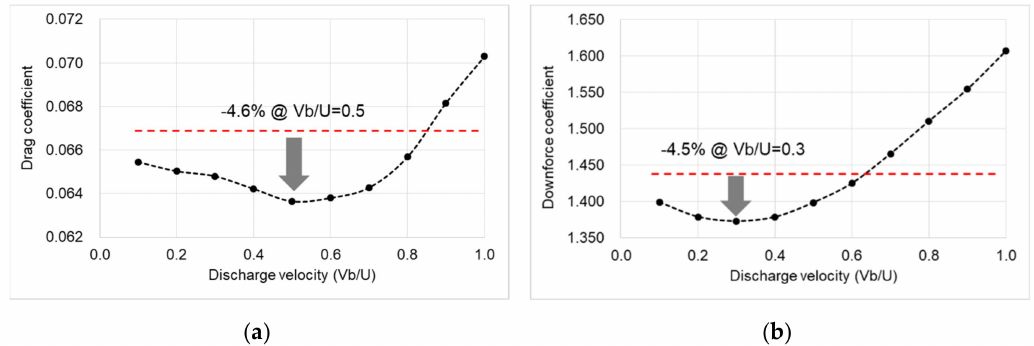
Figure 10. E ff ect of discharge velocity when the discharge position is 0.75C and the discharge is tangential to the vehicle driving direction; ( a ) Aerodynamic drag coe ffi cient; ( b ) Downforce coe ffi